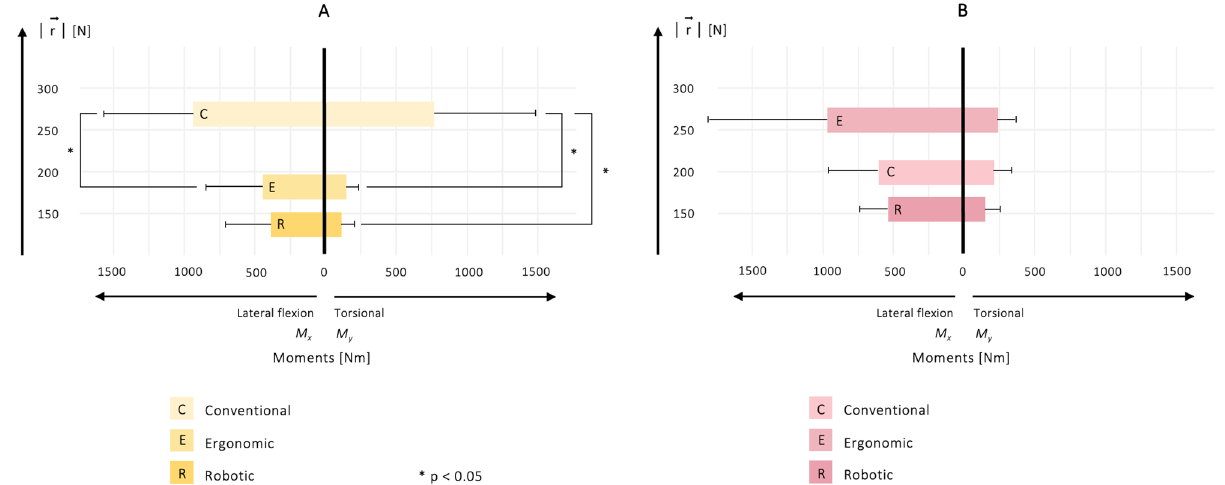
Figure 6. Illustration of the lateral flexion (M X ) and torsional (M Z ) moments for both groups and each manual patient handling task in relation to the mean maximum peak value of | the moments of lateral flexion; the right abscissa illustrates the moments of torsion. | ordinate. The results are presented with significant comparisons of the two-sided Wilcoxon signed rank test (see Supplementary Material, Table